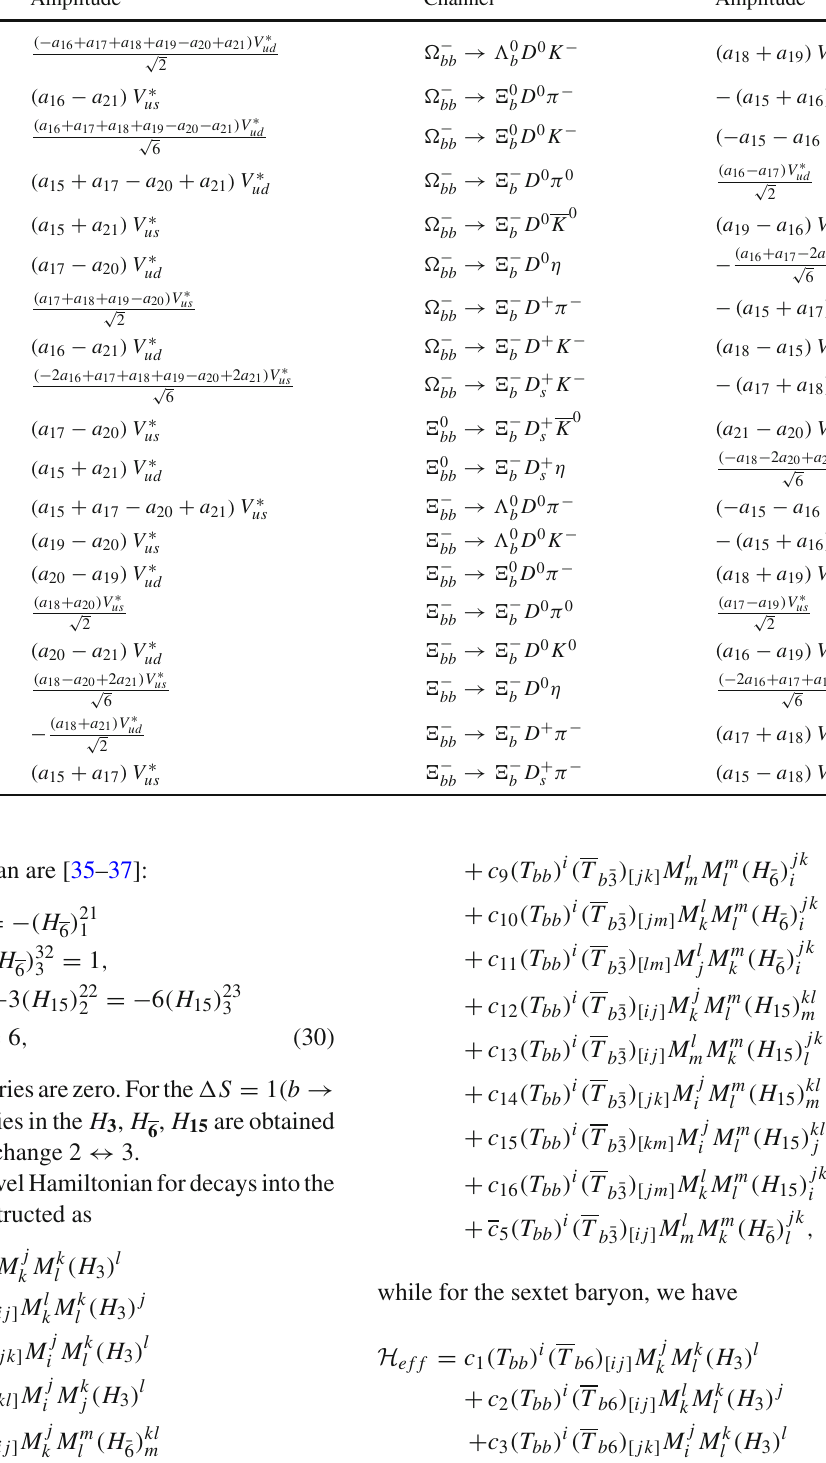
Table 18 Doubly bottom baryon decays into a bqq (anti-triplet), a charmed meson and a light meson Channel Amplitude Channel